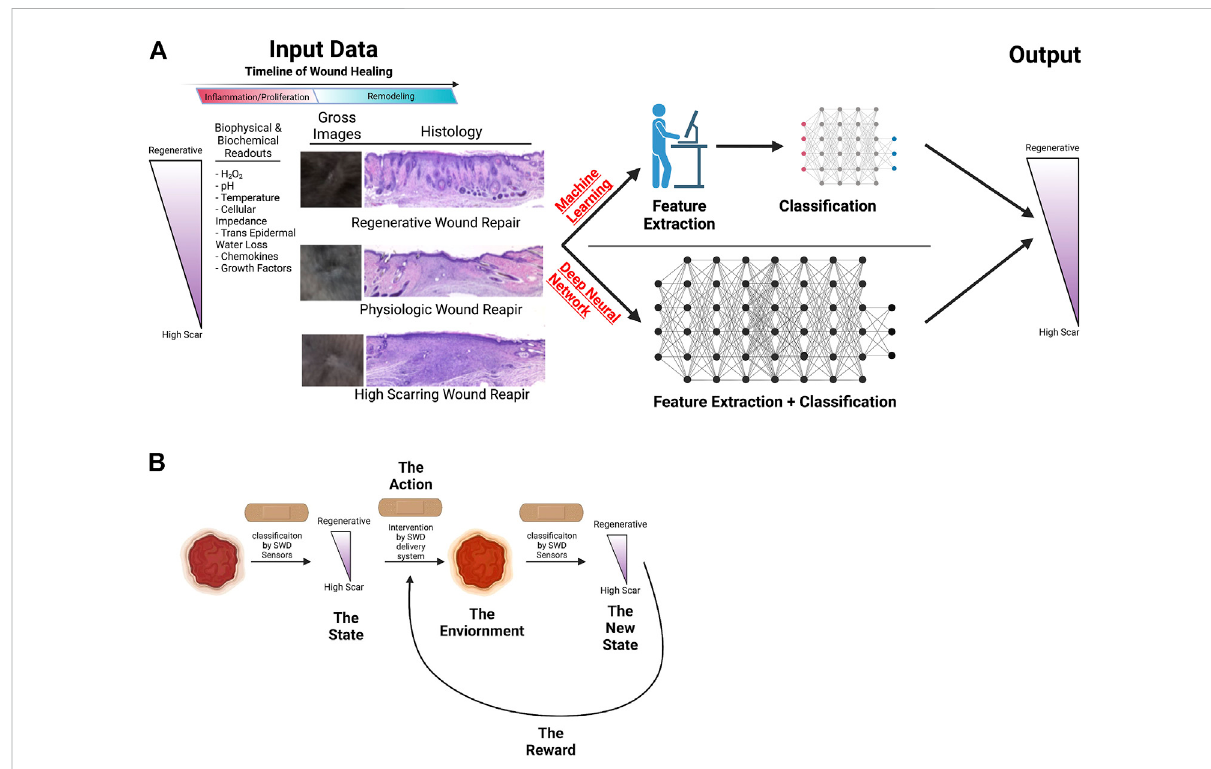
FIGURE 4 Illustration of potential machine learning applications to wound healing. (A) Schematic of machine learning vs. deep neural network use to improve wound healing outcomes. (B) Machine learning to modulate interventions to improve wound healing. Illustration created using